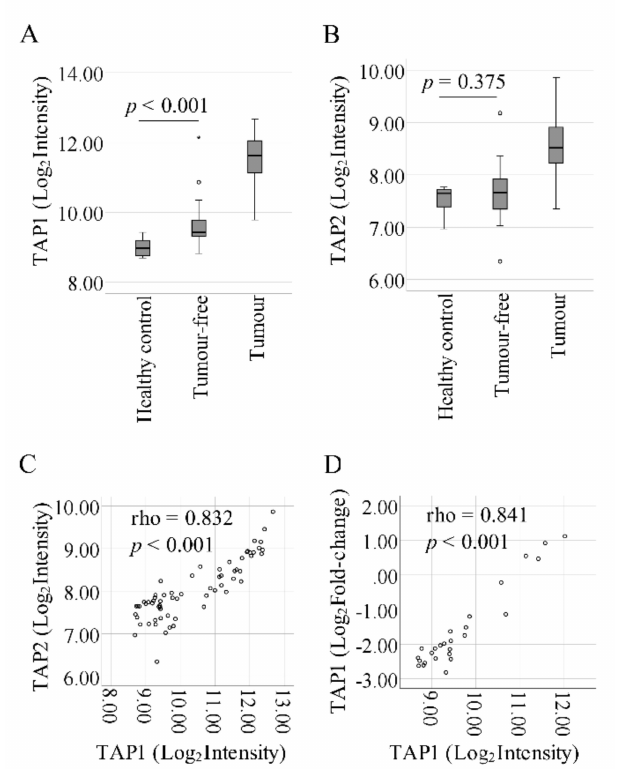
Figure 1. Microarray results of ( A ) TAP1 and ( B ) TAP2 mRNA levels in tongue from healthy volunteers, tumor-free samples and SCCOT samples. ( C ) Correlation between TAP1 and TAP2 levels ( p < 0.001). ( D ) Real-time quantitative PCR (RT-qPCR) confirmation of microarray data for TAP1 (spearman correlation coe ffi cient: 0.841, p <